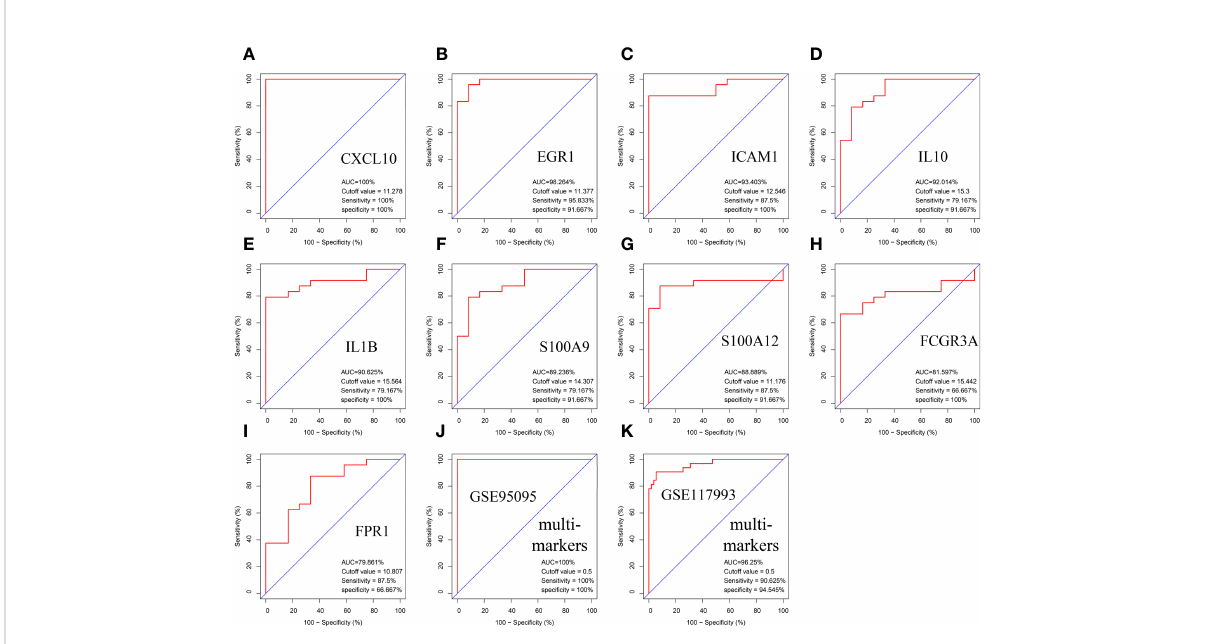
FIGURE 7 Validation of hub genes in the diagnostic value. (A – I) Validation of hub genes in the GSE95095. ROC curves and AUC statistics are used to evaluate the capacity to discriminate CD from healthy controls with excellent sensitivity and speci fi city. (J) Validation of the integrated